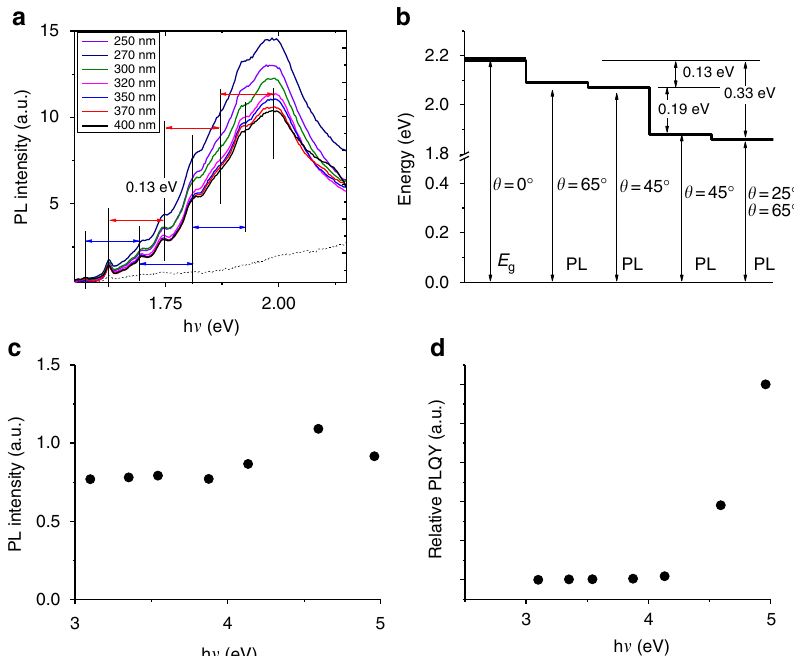
Fig. 5 Photoluminescence (PL) at difference excitation energies. a PL spectra of the powdered (CH 3 NH 3 ) 3 Bi 2 I 9 under different excitation energies. The blue and red arrows show the Stokes shift of 0.13 eV. The dashed line at the bottom is the PL measured on the substrate excited at 400 nm. b Energy diagram for the band gap of orientated fi lm and the peak energy of PL at different angles. c Integration of PL intensities at different excitation energies. d Relative PL quantum yield (PLQY) for the (CH 3 NH 3 ) 3 Bi 2 I 9 powder and coating on quartz,